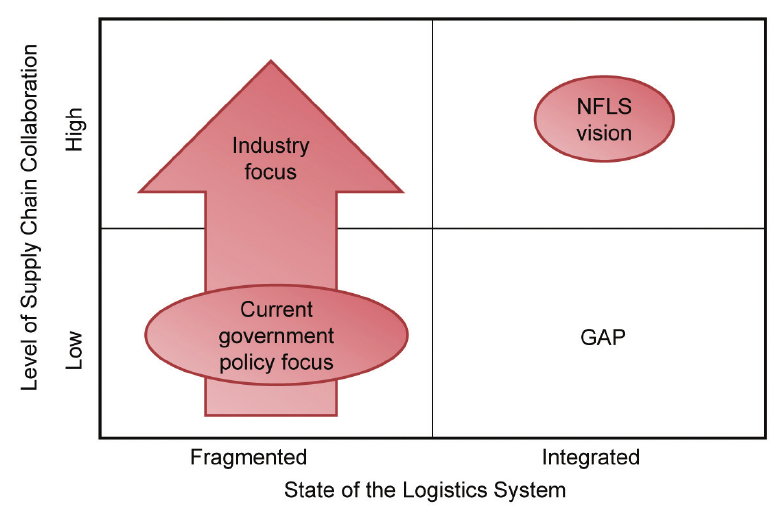
Figure 6: Drivers of competitive supply chains – applied to South